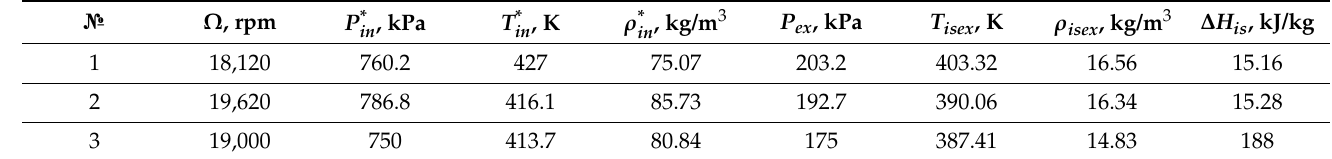
Table 4. ORC microturbine operational regimes. Inlet/outlet boundary conditions and isentropic quantities.